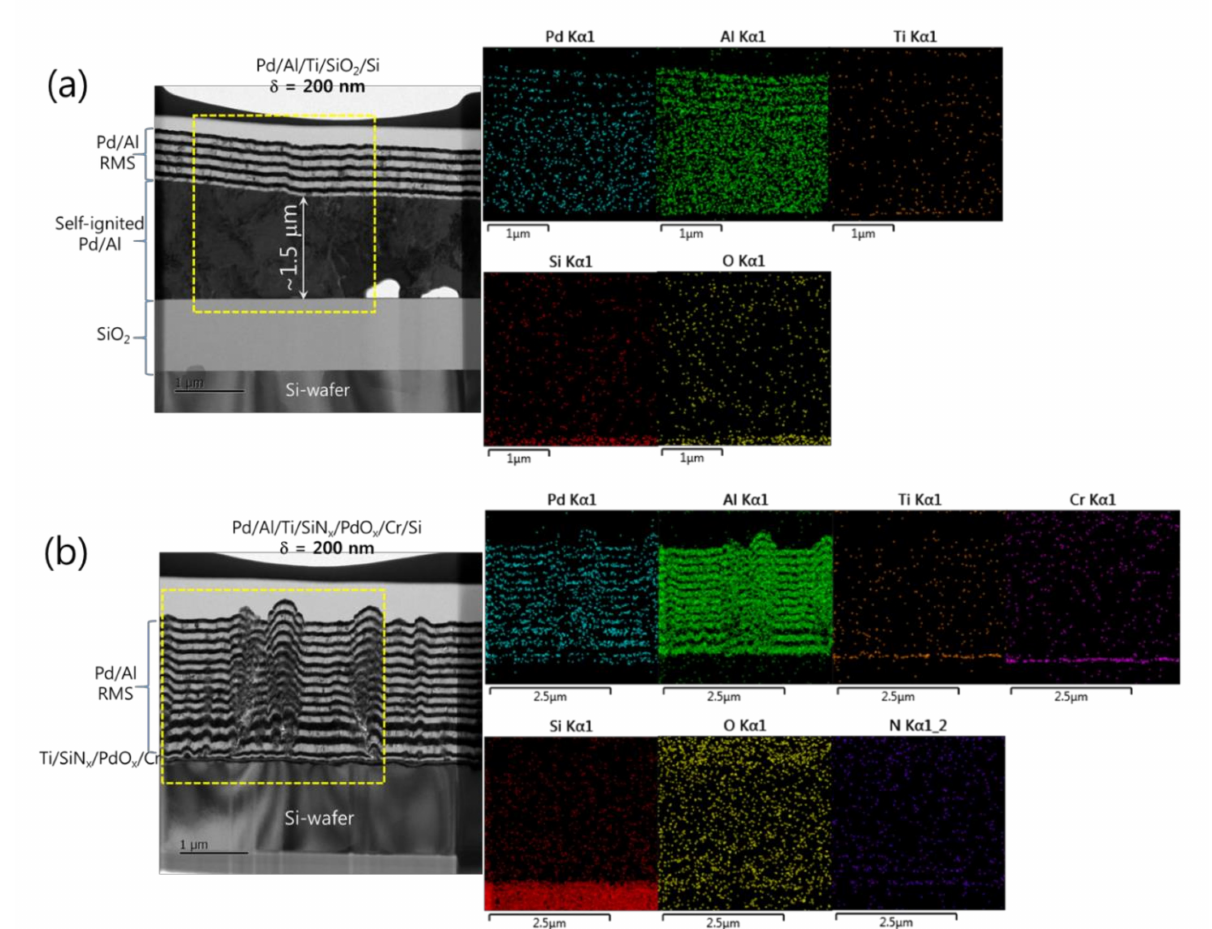
Figure 6. TEM cross sections ( left ) and corresponding EDS elemental mappings ( right ) of Pd/Al-iRMS with a bilayer thickness of δ = 200 nm and a bilayer number of N = 12. ( a ) Pd/Al-iRMS grown on a SiO 2 -coated Si-wafer; ( b ) Pd/Al-iRMS grown on a PdOx-buffered